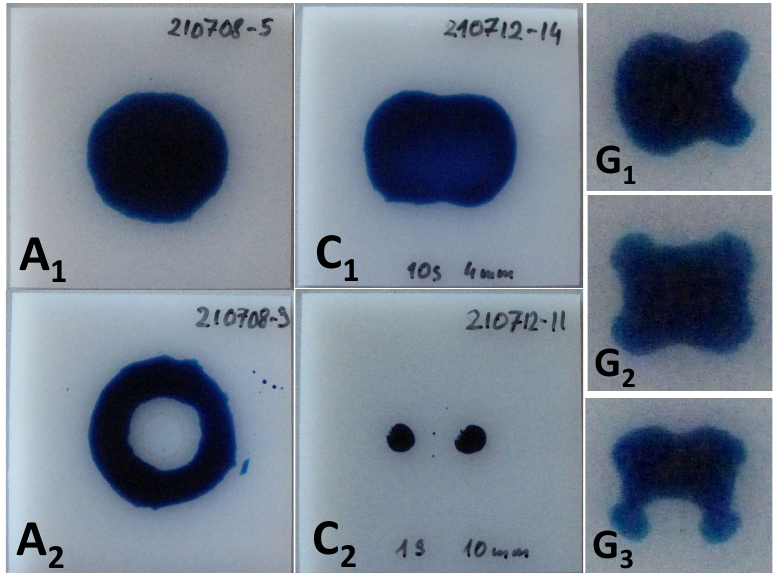
Figure 3. The shapes of the activation area visualized by the 58 mN/m test ink on the HDPE substrate for configurations A, C and G. The sizes of the substrates seen in pictures for A and C are 50 mm × 50 mm. The treatment times are 100 ms, 3 s, 10 s, 1 s and 20 s for A 1 , A 2 , C 1 , C 2 , and G 1 − 3